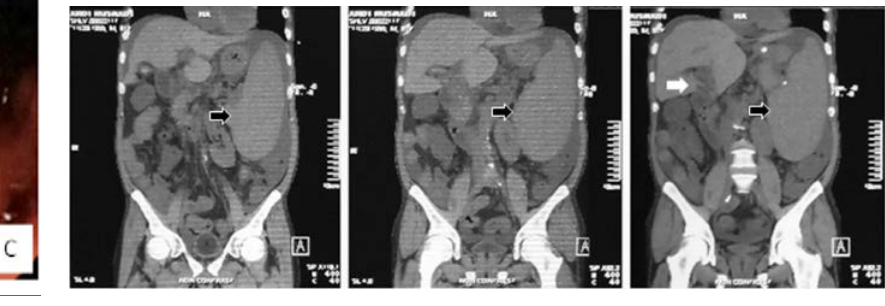
Figure 1. Esophagogastroduodenoscopy showing rupture of esophageal varives. Figure 2. Non-contrast abdominal computed tomographic scan